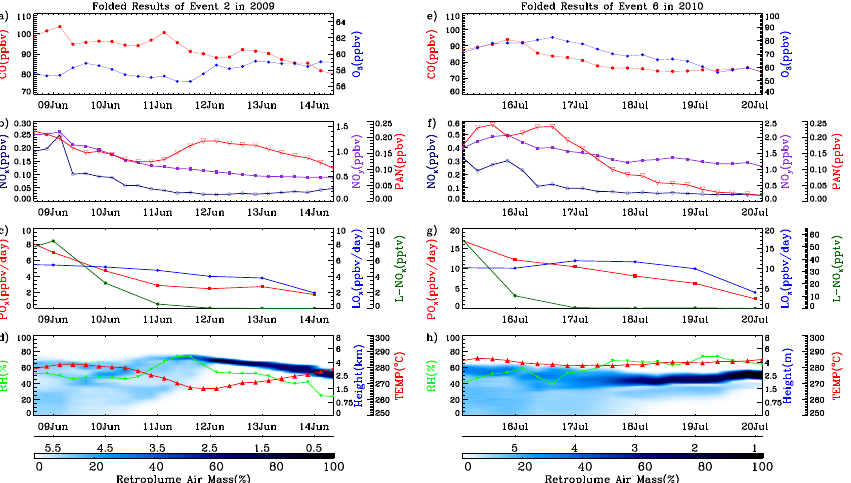
Fig. 6. Folded results (UFQs) of pollution plumes at each model time step during event 2 (left column) and 6 (right column). Data color corresponds to the respective y axes. Six-hour-averaged UFQs of tracer gases are shown in panels (a) , (b) , (e) and (f) . Folded daily averaged UFQs of ozone production ( P O x ) and loss ( L O x ) rates and lightning NO x (L-NO x ) are shown in panels (c) and (g) . FLEXPART retroplume, temperature, and RH in the folded results are shown in panels (d) and (h) , with dual x axes for date in UTC and upwind time in days.